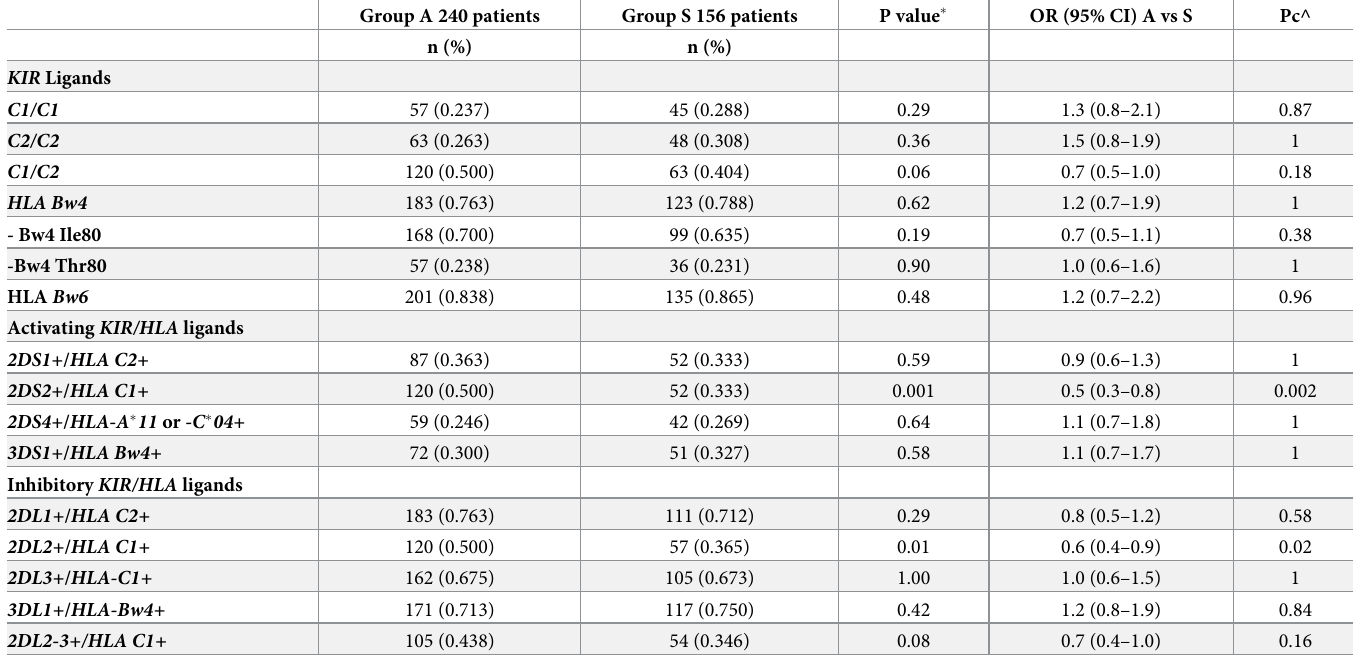
Table 5. Comparisons of KIR genes and their cognate ligands among COVID-19 patients divided according to severity of the clinical manifestations.